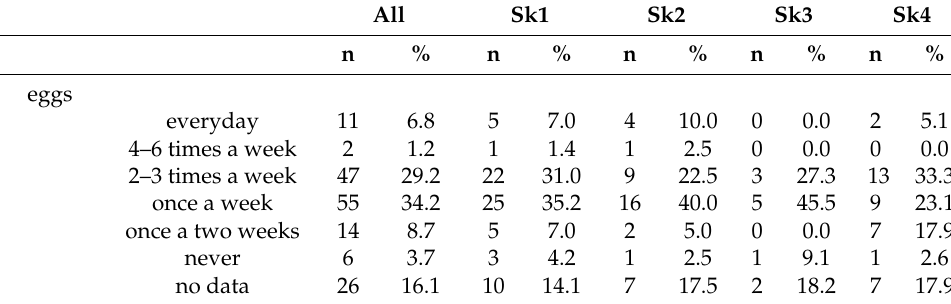
Table A6. Consumption of eggs among investigated